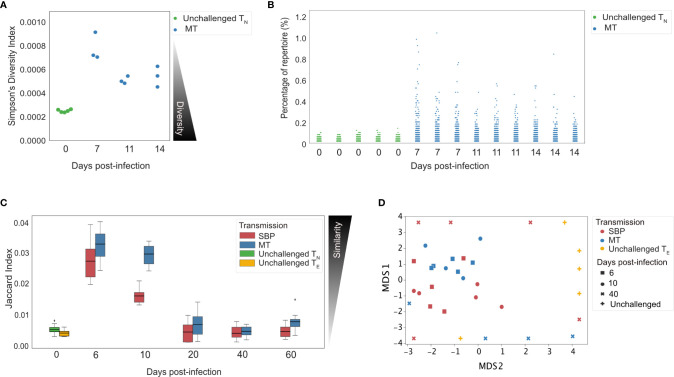
Splenic TE repertoires elicited by Plasmodium chabaudi are highly diverse. (A) Simpson’s Diversity Index (SI) for UMI-size matched unchallenged TN (green) and acute MT TE repertoires (blue). SI varies from 0 to 1, and for T-cell receptor (TCR) repertoires represents the probability that identical TCRs (as determined by identical CDR3 amino acid sequence) will be drawn from the repertoire with two independent draws. SI of 0 therefore represents maximal diversity. (B) Each point in the strip plot represents a clone and the percentage of repertoire they occupy, for individual replicate mice for TN unchallenged repertoires (green) and MT TE repertoires (blue). Data for (A, B) was normalized by down-sampling to 5000 UMI. (C) Similarity between replicate repertoires is demonstrated using the Jaccard index, a normalized sharing metric which represents the degree of clonal overlap between repertoires. Jaccard index varies form 0 (no similarity) to 1 (identical repertoires). TE replicate repertoires are more similar to each other in the acute phase of infection for both infection types. (D) Multi-dimensional-scaling (MDS) analysis using Jaccard similarity index of TE repertoires for unchallenged (yellow), MT (blue) and SBP (red) repertoires. Data for (C, D) was normalized by down-sampling to 104 reads and calculated on weighted data to include clonotype frequency.